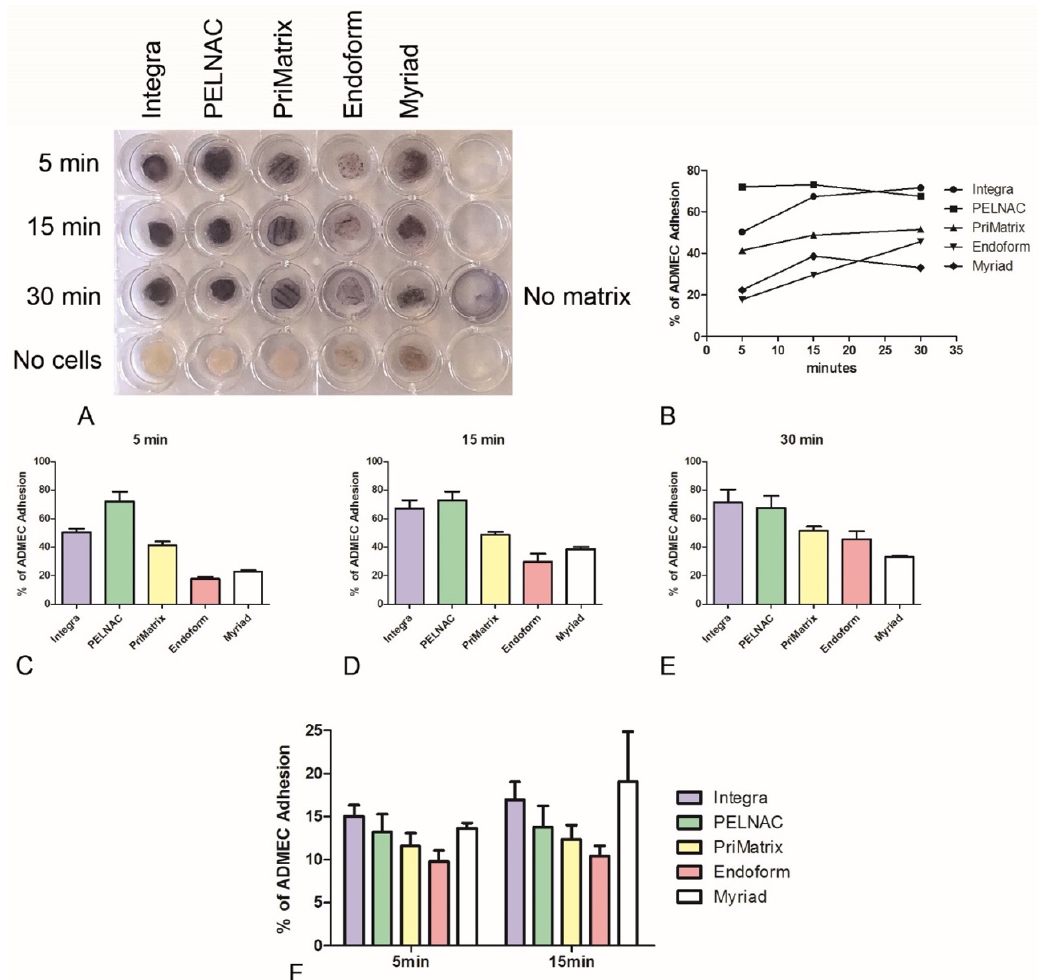
Figure 2. ( A – E ) ADMEC adhesion on Integra ® , PELNAC ® , PriMatrix ® , Endoform ® , or Myriad ® was evaluated by MTT assay. ADMECs were seeded onto the different matrices and incubated for three different durations (5, 15 and 30 min). After the removal of nonadherent cells, MTT was added and matrices were incubated at 37 °C for almost 4 h. ( A ) Picture of 24-well plate used for MTT assay before the solubilization of formazan crystals. ( B – E ) Formazan crystals were solubilized by adding DMSO; the absorbance was read at 570 nm by a plate reading spectrophotometer. Results are expressed as percentage of cell adhesion with reference to the absorbance obtained with the total number of seeded cells plated on fibronectin (the calculation formula is reported in the Supplementary Material). ( F ) ADMECs were labelled with the fluorescent dye FAST Dil, seeded onto different dermal substitutes and incubated for 5 or 15 min. After washing out the nonadherent cells from the scaffolds, labelled cells were lysed to release the dye in solution; the fluorescence was read with an Infinite200 TECAN reader. Results are expressed as percentage of cell adhesion with reference to a calibration curve established with an increasing number of labelled cells. Data from six independent experiments are presented as mean ± SE.